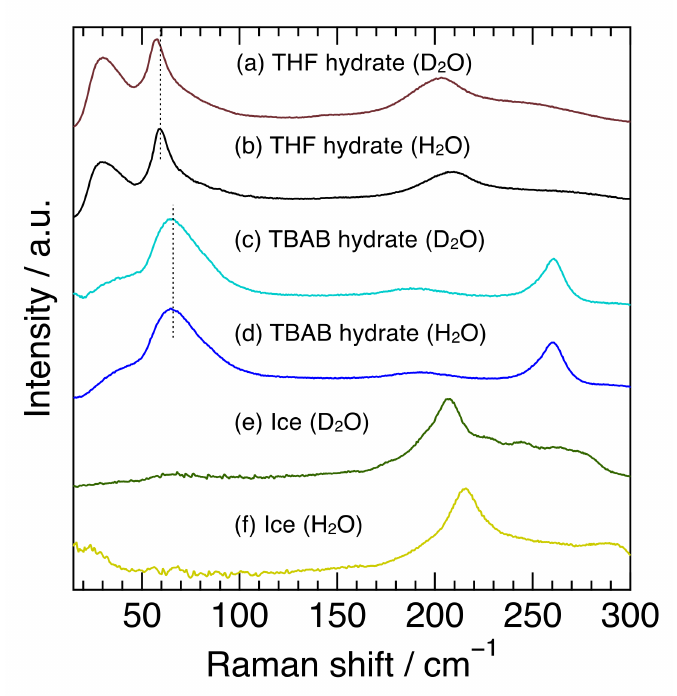
Figure 1. Raman spectra for THF hydrate, TBAB hydrate, and ice with H 2 O or D 2 O. The dotted vertical lines around 65 cm − 1 from (a–d) were used to make it easier to see a peak shift. In the region below 100 cm − 1 , TBAB hydrate (H 2 O) had a broad peak around 67 cm − 1 and THF hydrate (H 2 O) had a sharp peak at 59 cm − 1 , although no clear peak was observed in ice. The sharp peak of THF hydrate was attributed to the host water framework in structure-II clathrate hydrate [28]. The Raman and inelastic neutron scattering (INS)